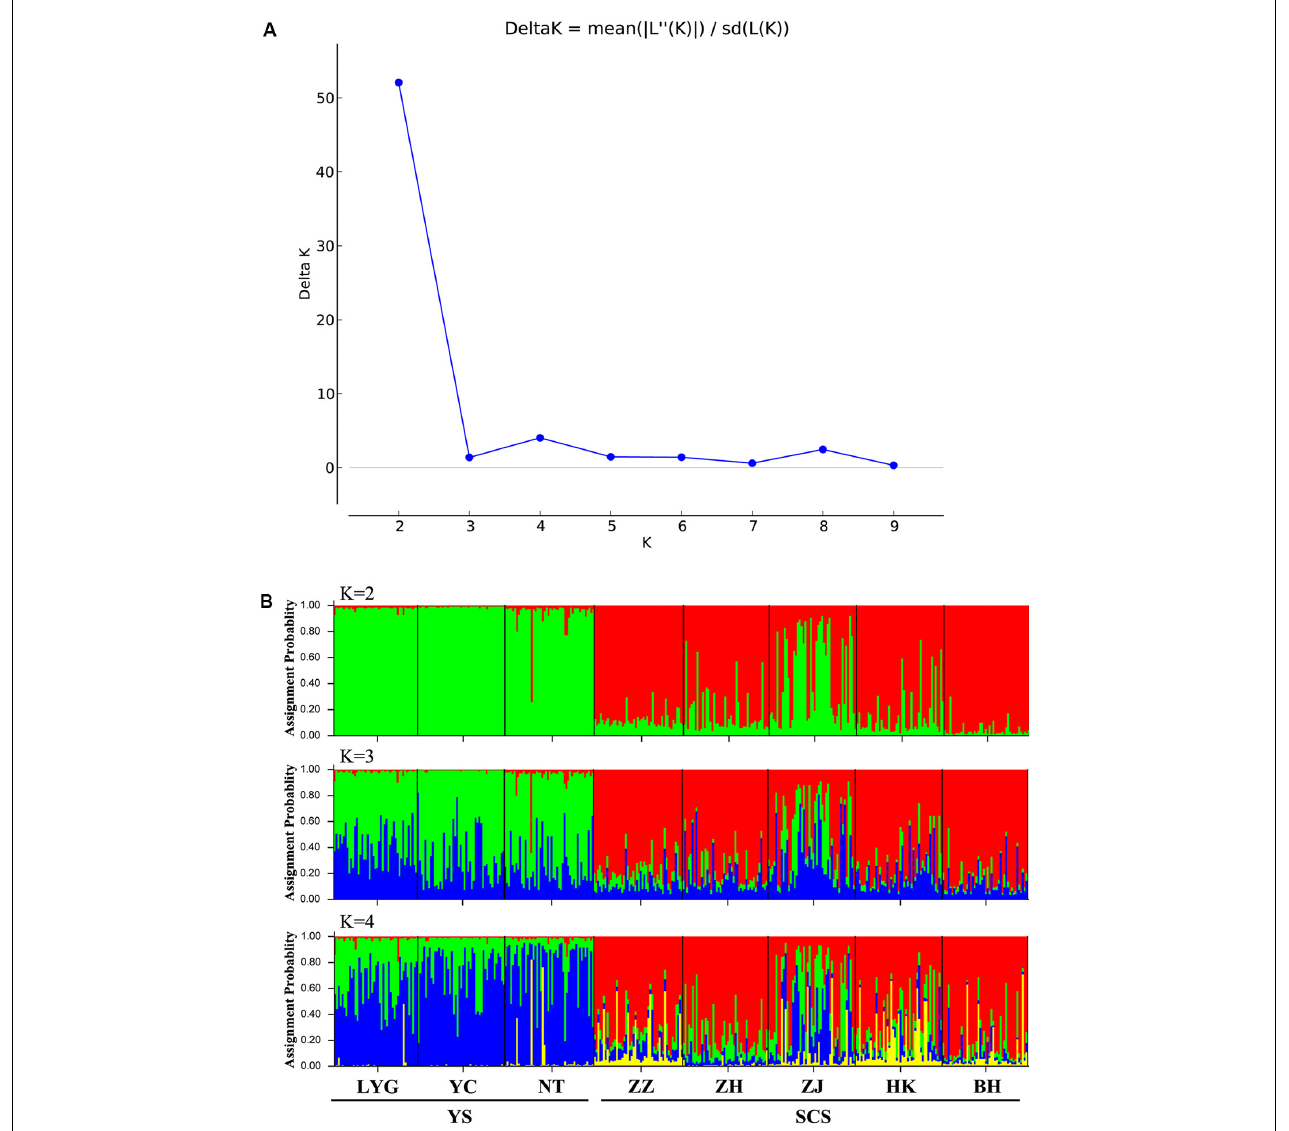
FIGURE 3 | (A) Magnitude of (cid:49) K statistics as a function of the number of putative genetic clusters, K , for Chinese populations of M. meretrix based on six microsatellite loci. (B) Results of STRUCTURE analysis with membership coefficients of 374 M. meretrix individuals for K =2 collected from eight locations along the Chinese coast based on six polymorphic microsatellite